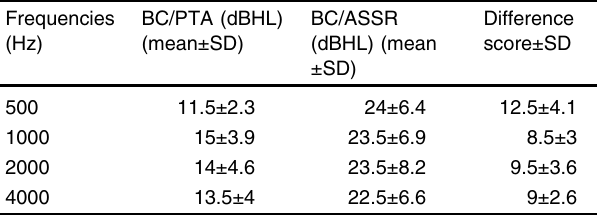
Table 5 BC/PTA and BC/ASSR thresholds and the difference score in children with